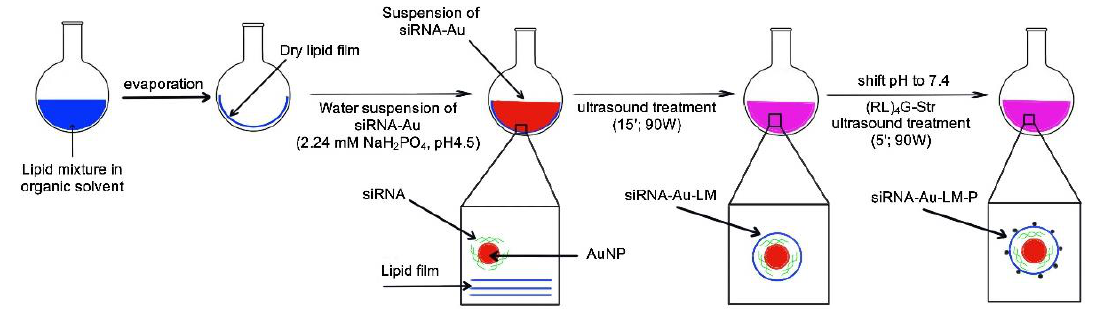
Figure 7. Scheme of sequential steps of nanoconstruction (siRNA-Au-LM-P) preparation.